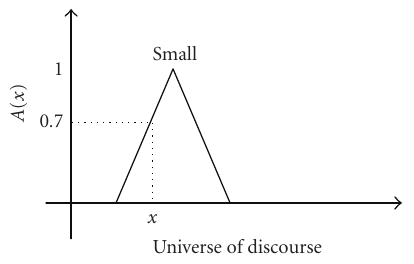
Figure 1: A triangular membership function of the fuzzy set “Small.”